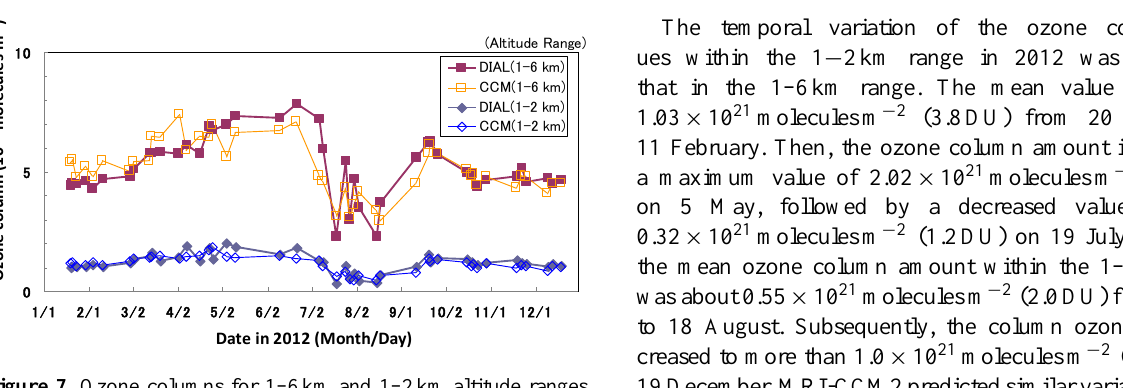
Figure 7. Ozone columns for 1–6km and 1–2km altitude ranges over Saga in 2012 measured by DIAL and predicted by MRI-